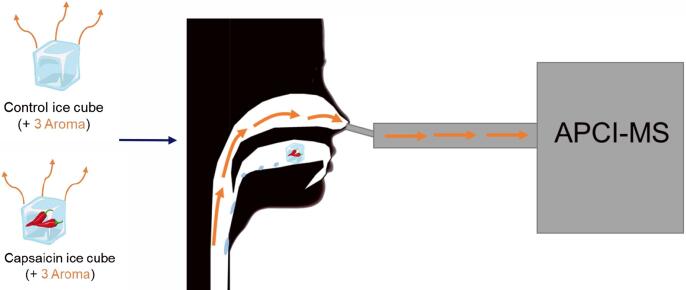
Schematic diagram of experimental design for the in-vivo study.